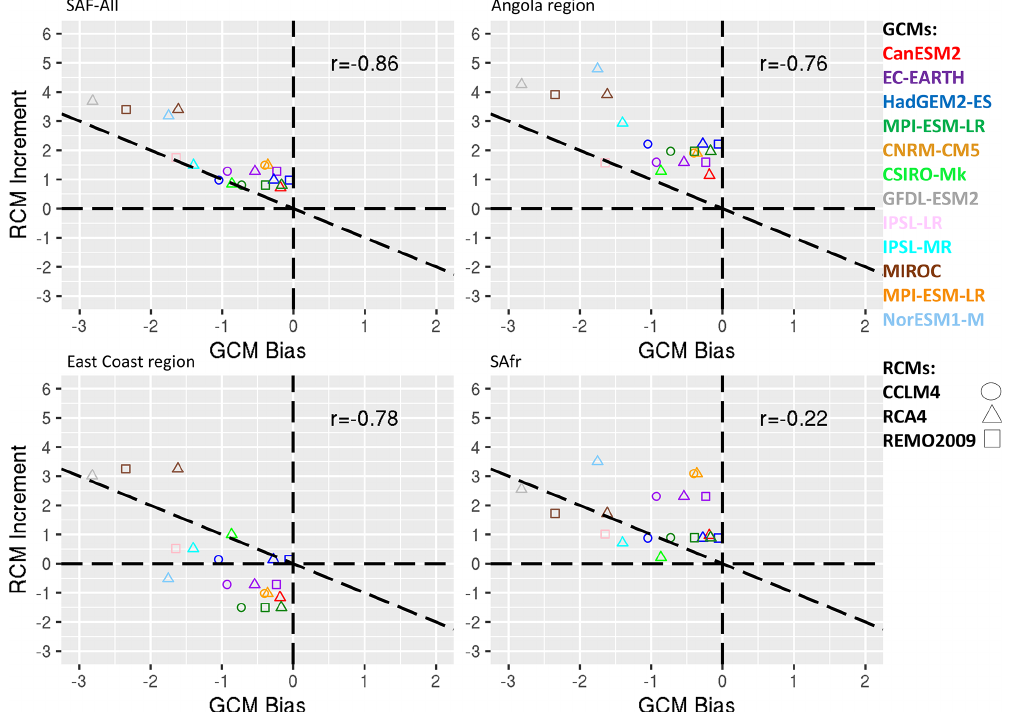
Figure 8. Scatterplots of the RCM increment (RCM − GCM) for precipitation (mmd − 1 ) as a function of the GCM bias (GCM-OBS) for January. Colours indicate the driving GCM, and shapes indicate the downscaling RCMs. The four panels indicate spatial averages over southern Africa (SAF-All region), the Angola region, the East Coast region and the SAfr region,